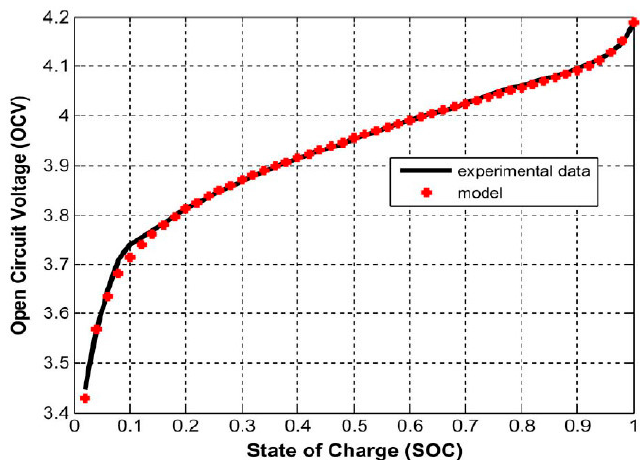
Figure 3. OCV-SoC characteristic curve [22].